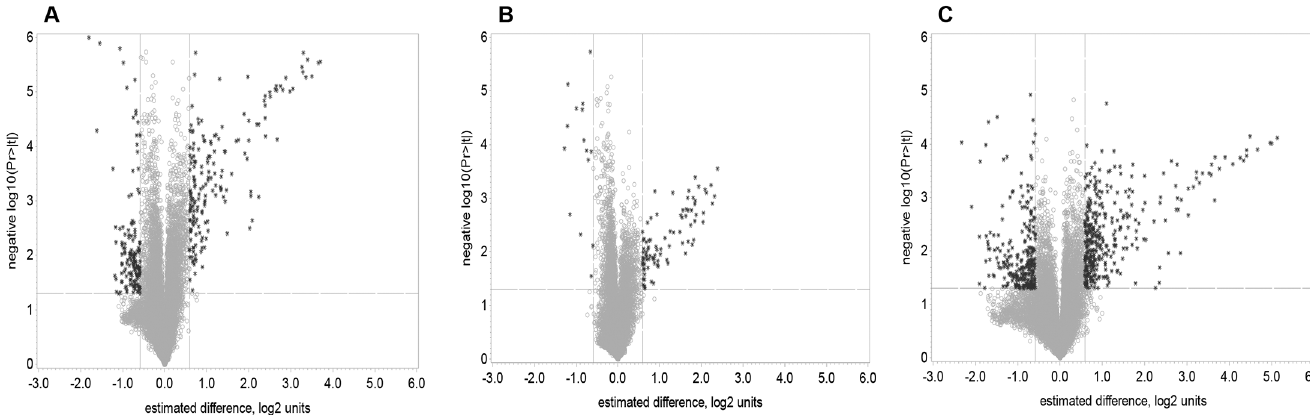
Fig 1. Volcano plots of log2 fold change (x-axis) versus – log10 of unadjusted P-values (y-axis), representing the probability that the gene is differentially expressed in PBC of breast cancer patients treated with DOX-based chemotherapy in data of average before versus after one dose of DOX-based chemotherapy. (A) comparison of average before vs after of all patients; (B) average before vs after in patients with normal LVEF after the completion of chemotherapy; (C) average before vs after in patients with abnormal LVEF after the completion of chemotherapy. P < 0.05; FDR <